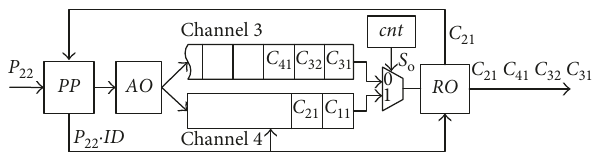
Figure 8: Dual-channel control of output module.